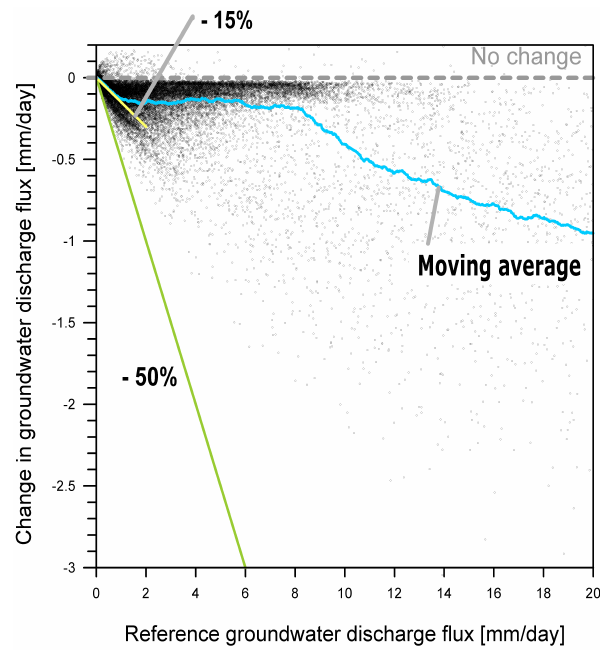
Fig. 11. Scatter-plot showing for all MODFLOW grid cells, which have an average groundwater discharge flux (drain and river leak- age) between 0 and 20 mmday − 1 (x-axis), the difference in ground- water discharge flux between the reference period (1960–1991) and the average of the 28 climate change scenarios (2071–2101) (y- axis). The moving average is calculated over a range of 500 suc- cessive values. The lines indicate the 50% and 15% decrease in groundwater discharge